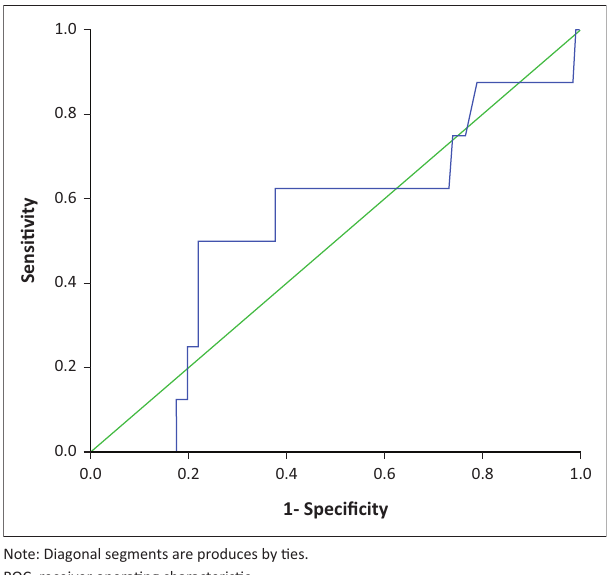
FIGURE 3: Red cell distribution width ROC curve in β-thalassaemia in western Kenya from 01 January 2015 – 31 December